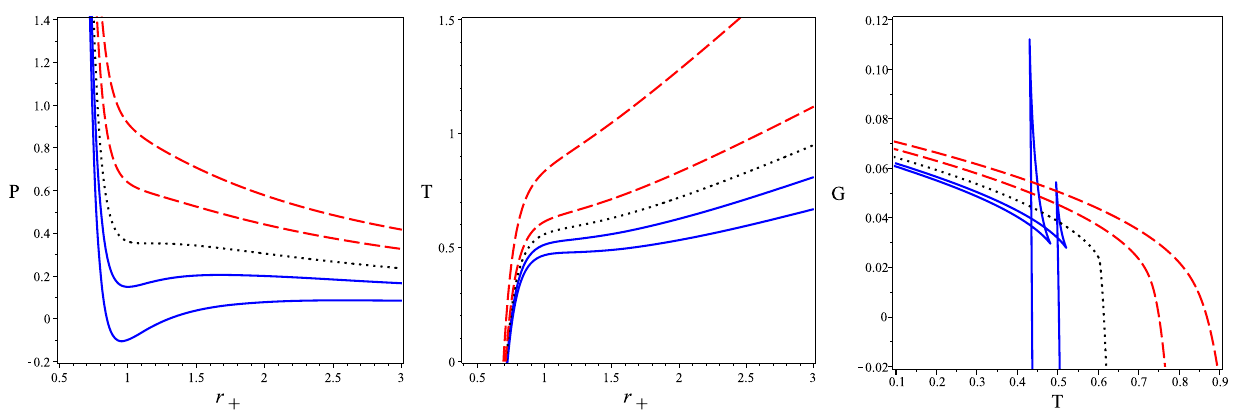
line) and T > T c (dashed lines). Middle and right panels: P < P c (continuous lines), P = P c (dotted lines) and P > P c (dashed